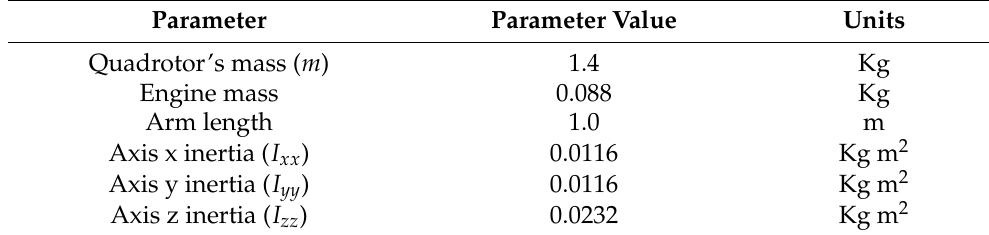
Table 1. Parameters used for the real-time simulation of the drone dynamic model